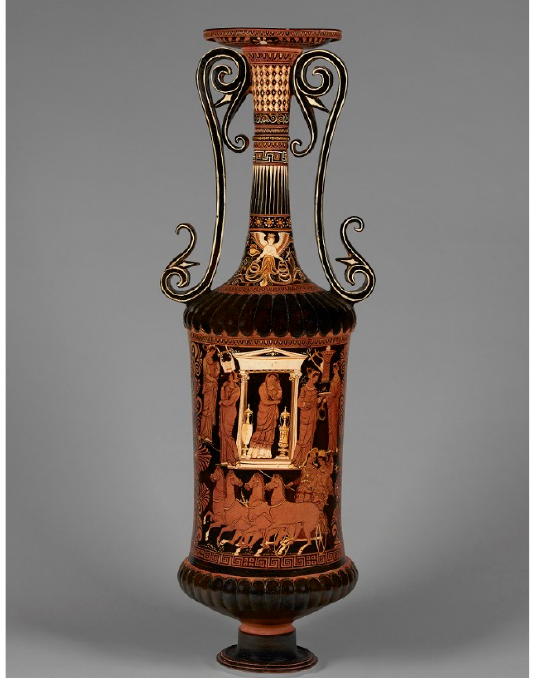
Figure 14. Malibu, J. Paul Getty Museum 82.AE.16 Apulian red-figure loutrophoros, Painter of Louvre MNB 1148, ca. 330 B.C. Winged female wearing a polos and terminating tendrils in floral surround (neck) and the mourning of Niobe in a naiskos with Pelops and Hippodamia driving up in a chariot to urge her to stop grieving (body). Digital image courtesy of the Getty Open Content Program.